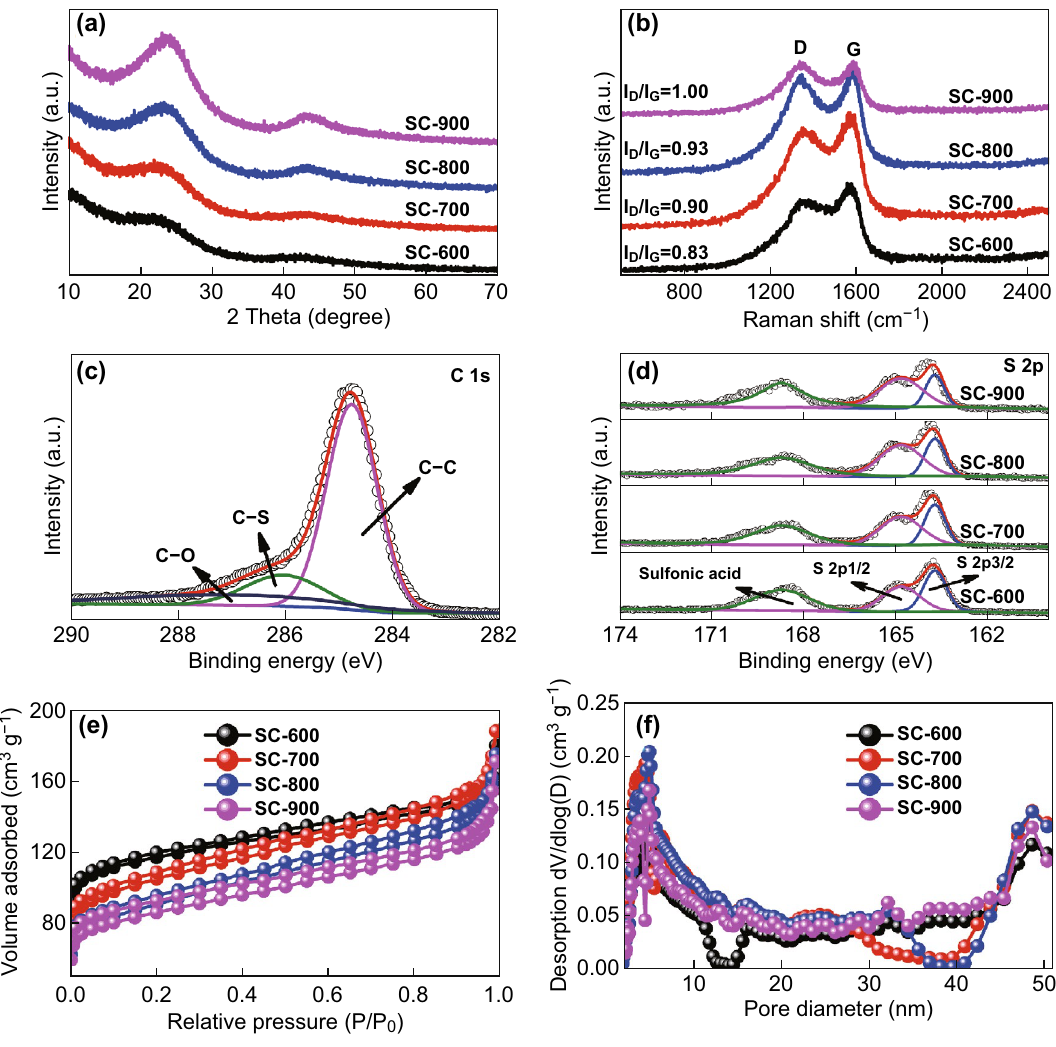
Fig. 2 a XRD patterns and b Raman spectra of SC-600, SC-700, SC-800, and SC-900. c XPS C 1s profile of SC-800. d XPS S 2p profiles. e Nitrogen sorption isotherms and f pore-size distributions of SC-600, SC-700, SC-800, and